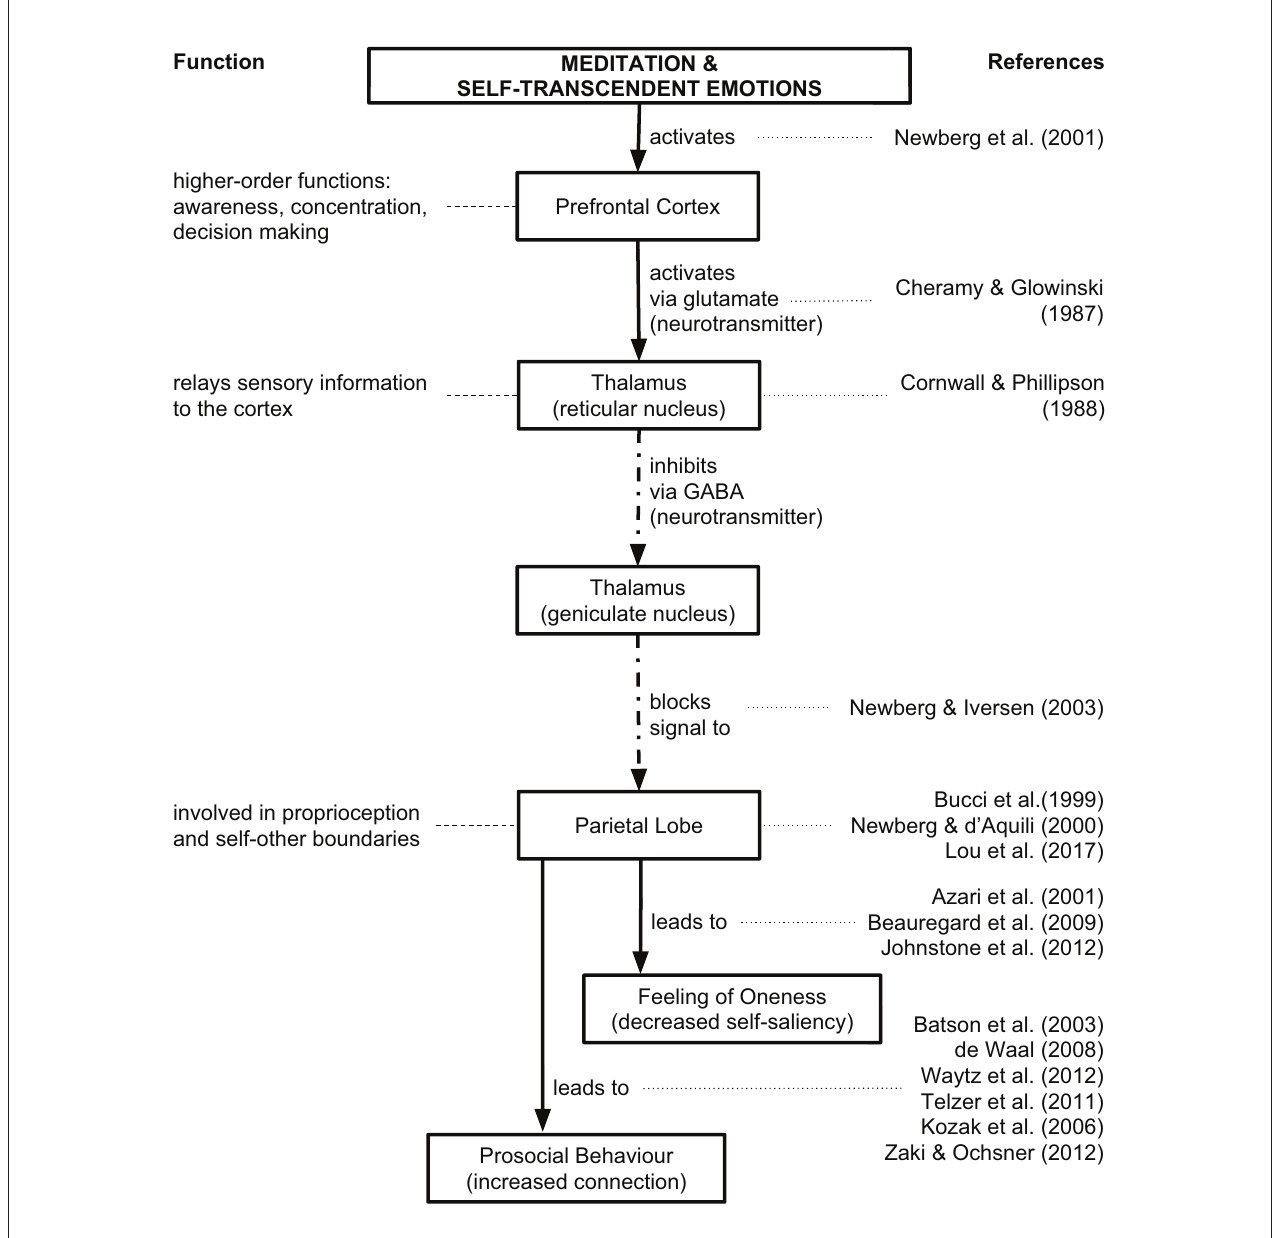
FIGURE 3 | Neurological processes relating to self-transcendence. For a review, see (Newberg, 2014; Yaden et al., 2017a,b).